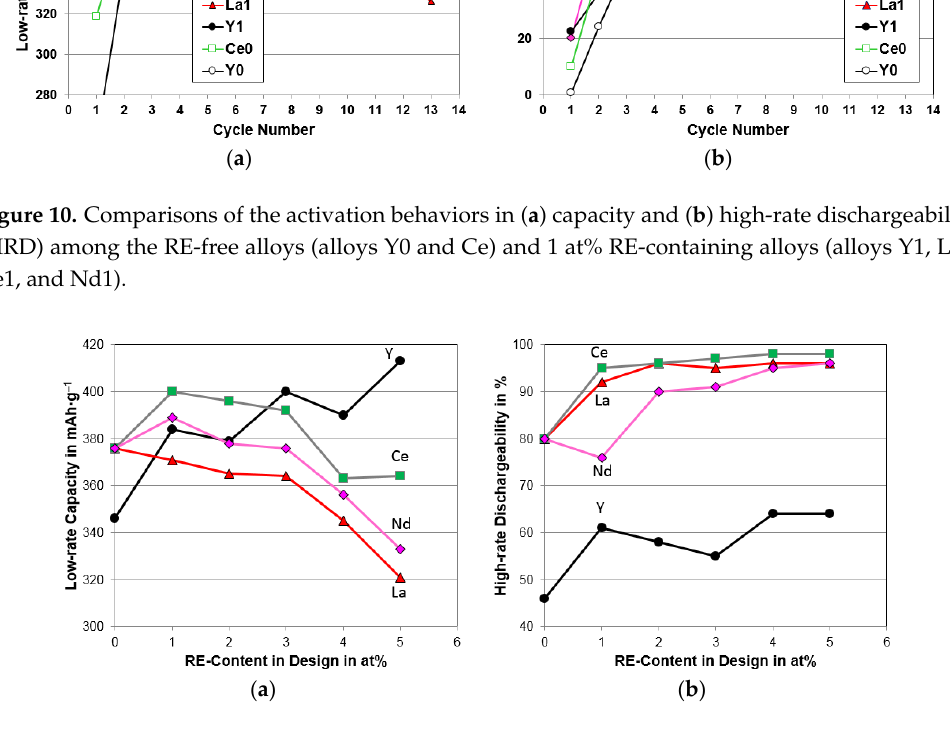
Figure 10. Comparisons of the activation behaviors in ( a ) capacity and ( b ) high-rate dischargeability (HRD) among the RE-free alloys (alloys Y0 and Ce) and 1 at% RE-containing alloys (alloys Y1, La1, Ce1, and Nd1). Table 6. Summary of electrochemical half-cell and magnetic measurements, including the capacities at the third cycle, HRD at the third cycle, number of cycles needed to achieve 92% HRD, bulk diffusion coefficient, surface exchange current, results from AC impedance measurements, saturated magnetic susceptibility, and applied field at half of the saturated magnetic susceptibility.